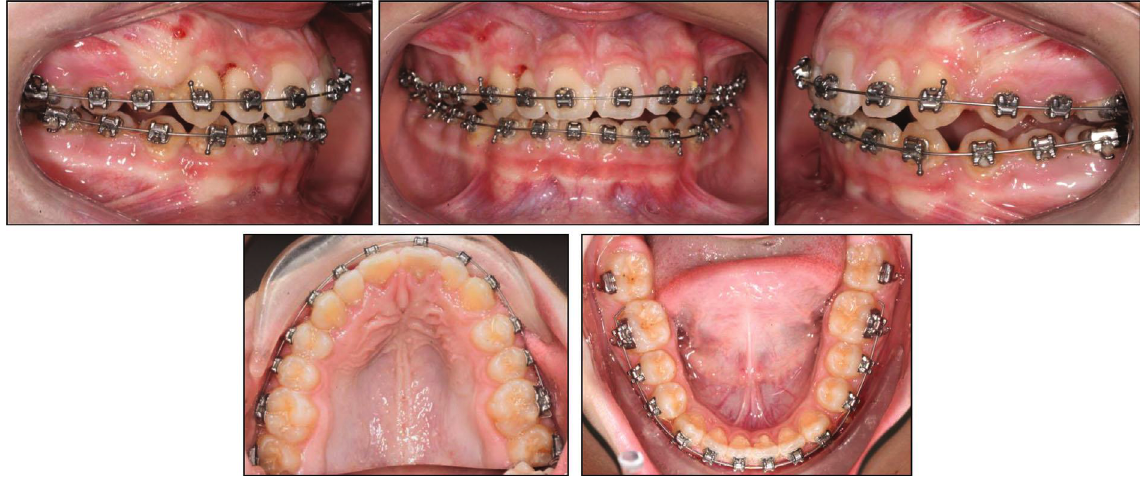
Figure 9: The patient ’ s intraoral photographs taken after 3 weeks of leveling and alignment with the 0.012 ″ Ni – Ti round